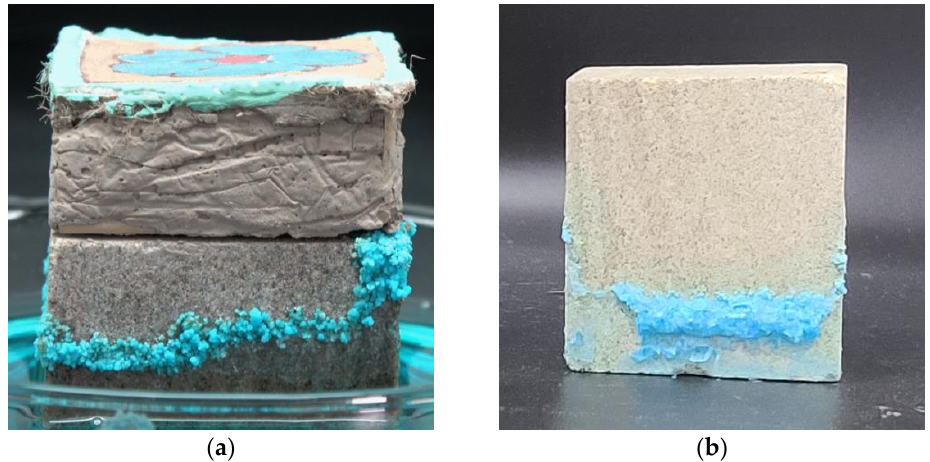
Figure 6. Inverted parabolic shapes formed by crystals ( a ) salt belt on the sample shot from a different angle; ( b ) another simulated sample whose bottom was soaked with less salt solution.